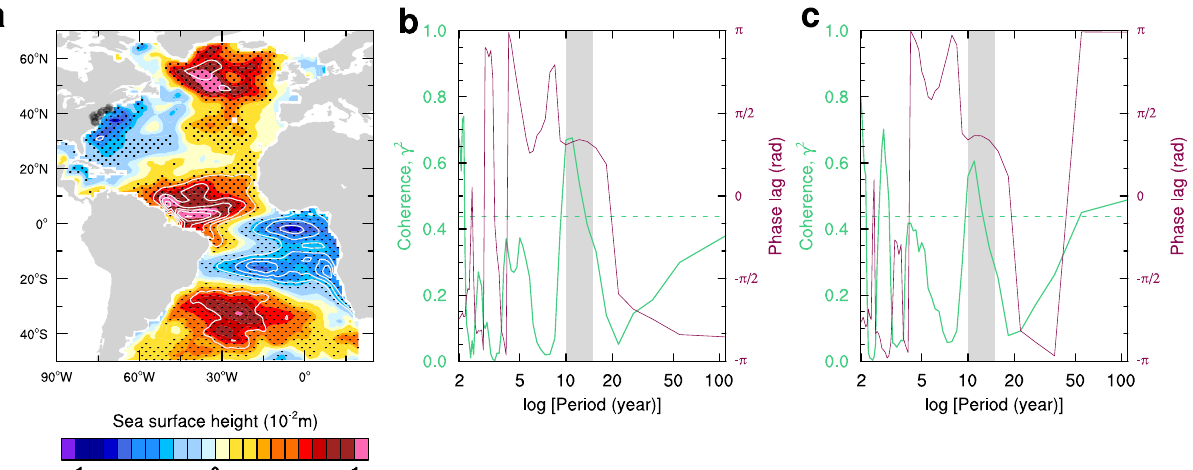
Fig. 3 Relating SST PC2 to sea surface height and sea-level index. a Monthly anomalies of sea surface height regressed onto the normalized SST PC2 time series. Stippling denotes statistical signi fi cance at 95% con fi dence level; white contours denote explained variances at interval of 3%. The tide-gauge sites used along the United States northeast coast 37 – 42°N are marked black. b , c Coherence (left axis) and phase lag (right axis) between sea-level index and b SST PC2 and c ITCZ. The sea-level index leads (follows) PC2/ITCZ at positive (negative) lags. The vertical grey bar shows the 10 – 15 year period band. The dashed horizontal line denotes 95% con fi dence level for squared